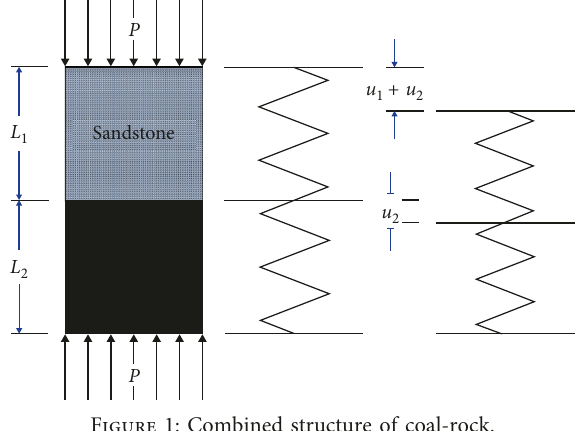
Figure 1: Combined structure of coal-rock.